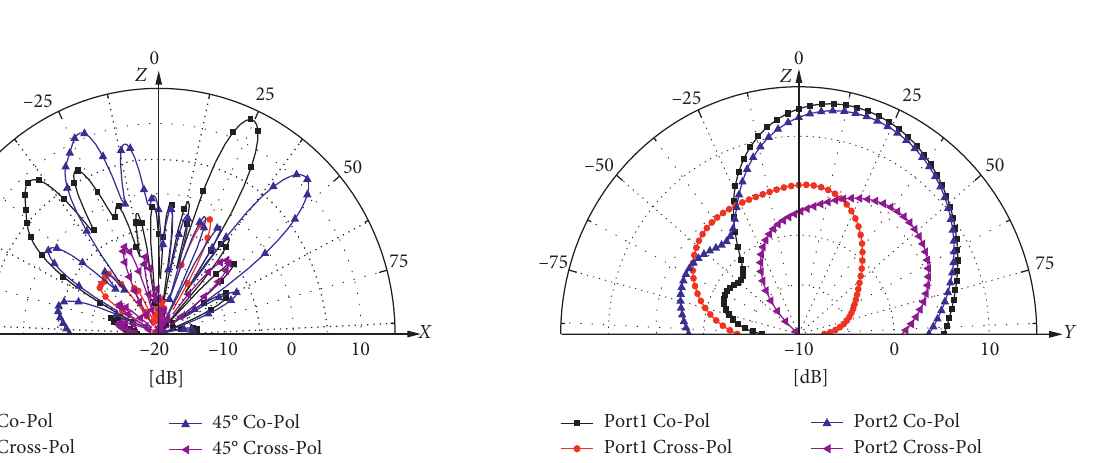
Figure 11: Simulated radiation pattern of the array. (a) θ xoz � 25 ° . (b) θ xoz � 45 ° .